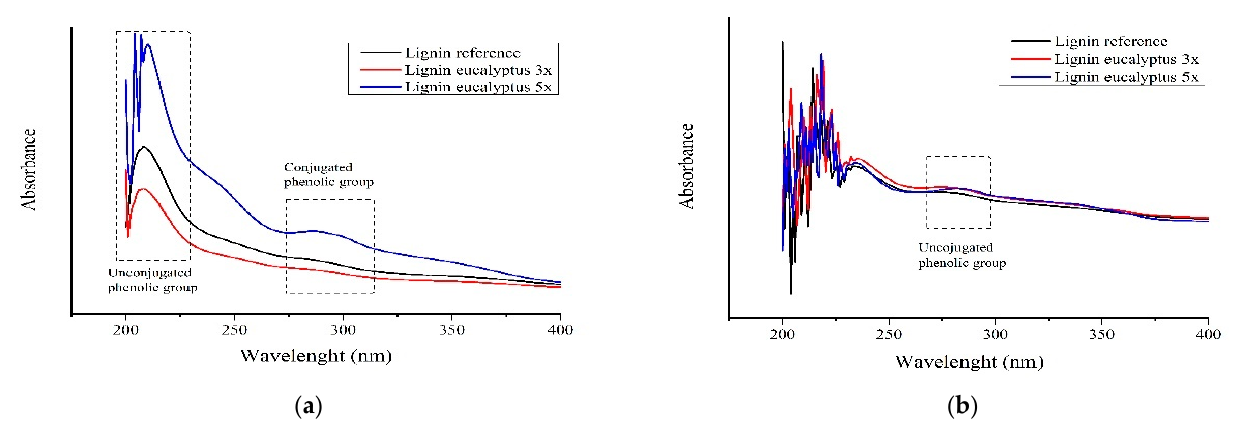
Figure 4. Solubility of Eucalyptus lignin after 3× and 5× washing treatment in NaOH ( a ) and dioxane-distilled water ( b ) with absorbance UV. dioxane-distilled water ( b ) with absorbance